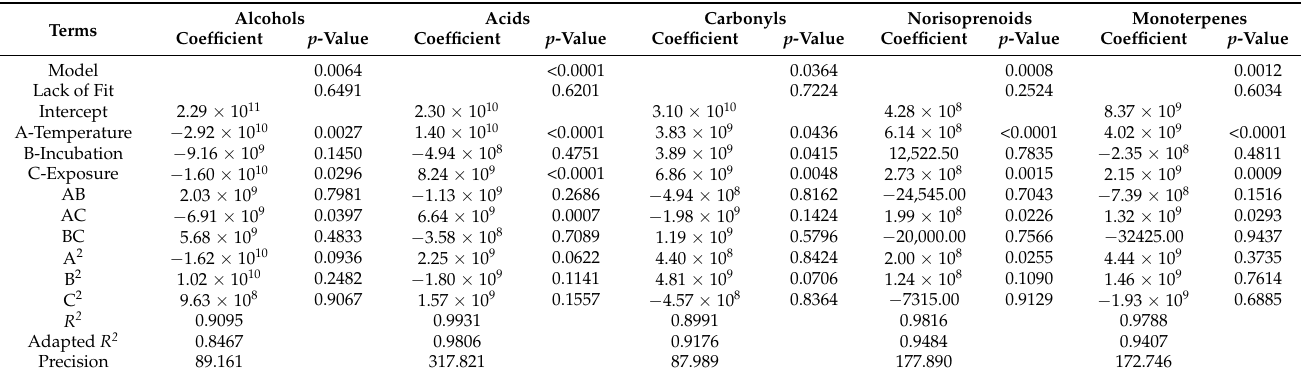
Table 3. Coefficients of the second order polynomial equation and regression coefficients of response and ANOVA parameters for obtained models for bound